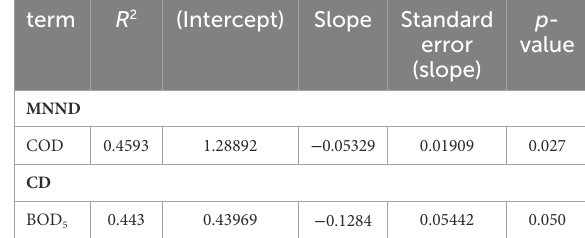
TABLE 4 Results of linear regression between environmental factors and mean nearest neighbour distance (MNND) and distance to centroid